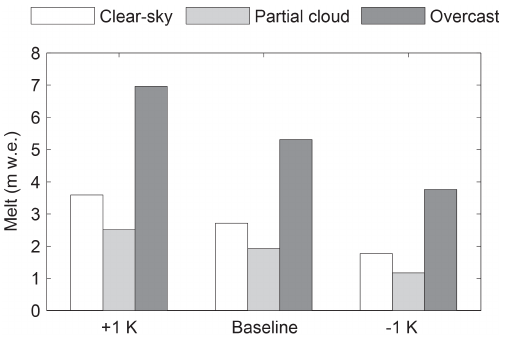
Figure 8. Total surface melt in each cloud cover category for base- line and climate perturbation scenarios.